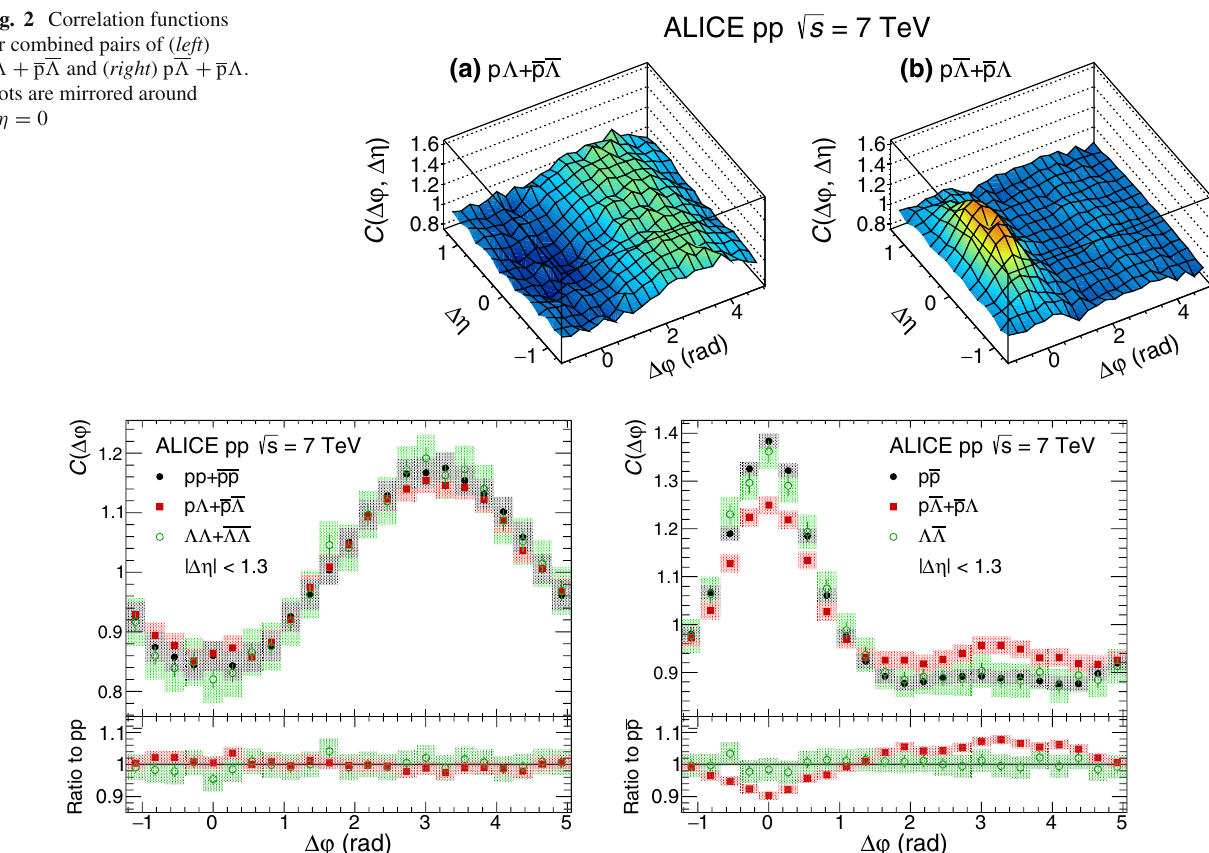
Fig. 3 (cid:3)η integrated projections of correlation functions for combined pairs of ( left ) pp + pp, p (cid:5) + p (cid:5) , and (cid:5)(cid:5) + (cid:5)(cid:5) and ( right ) pp, p (cid:5) + p (cid:5) , and (cid:5)(cid:5) . Statistical ( bars ) and systematic ( boxes ) uncertainties are